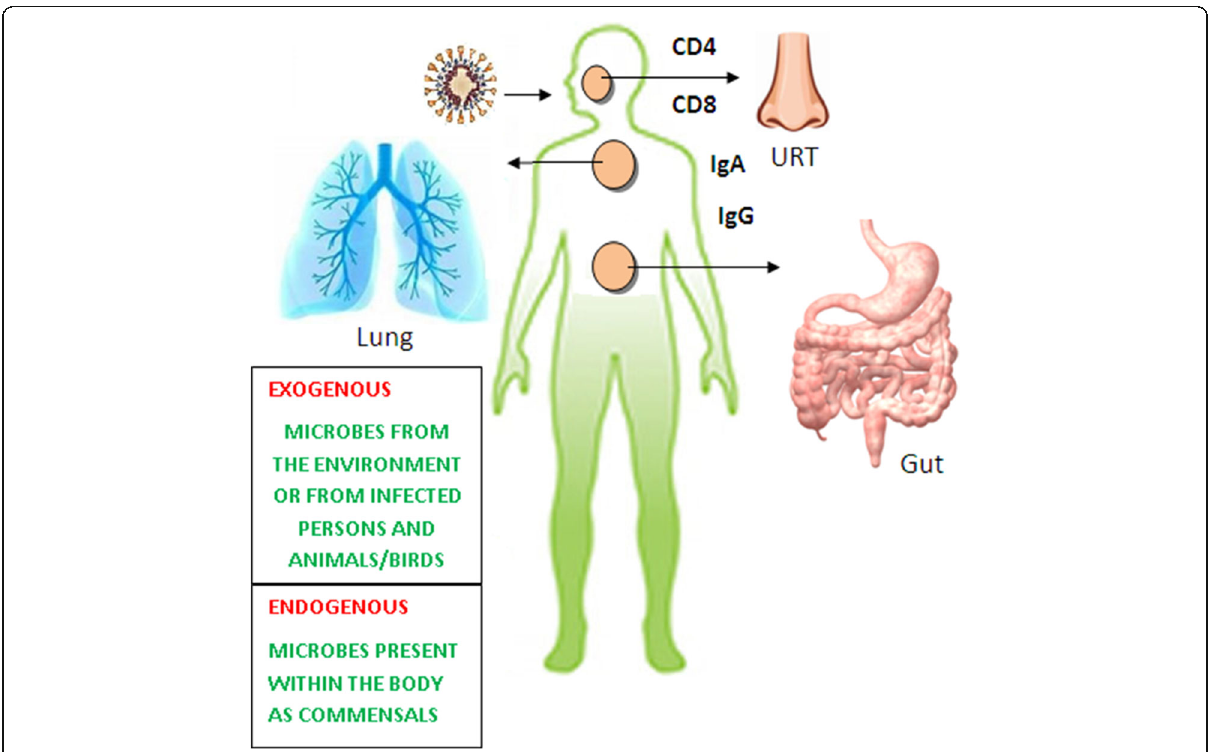
Fig. 1 Coinfections observed in COVID-19